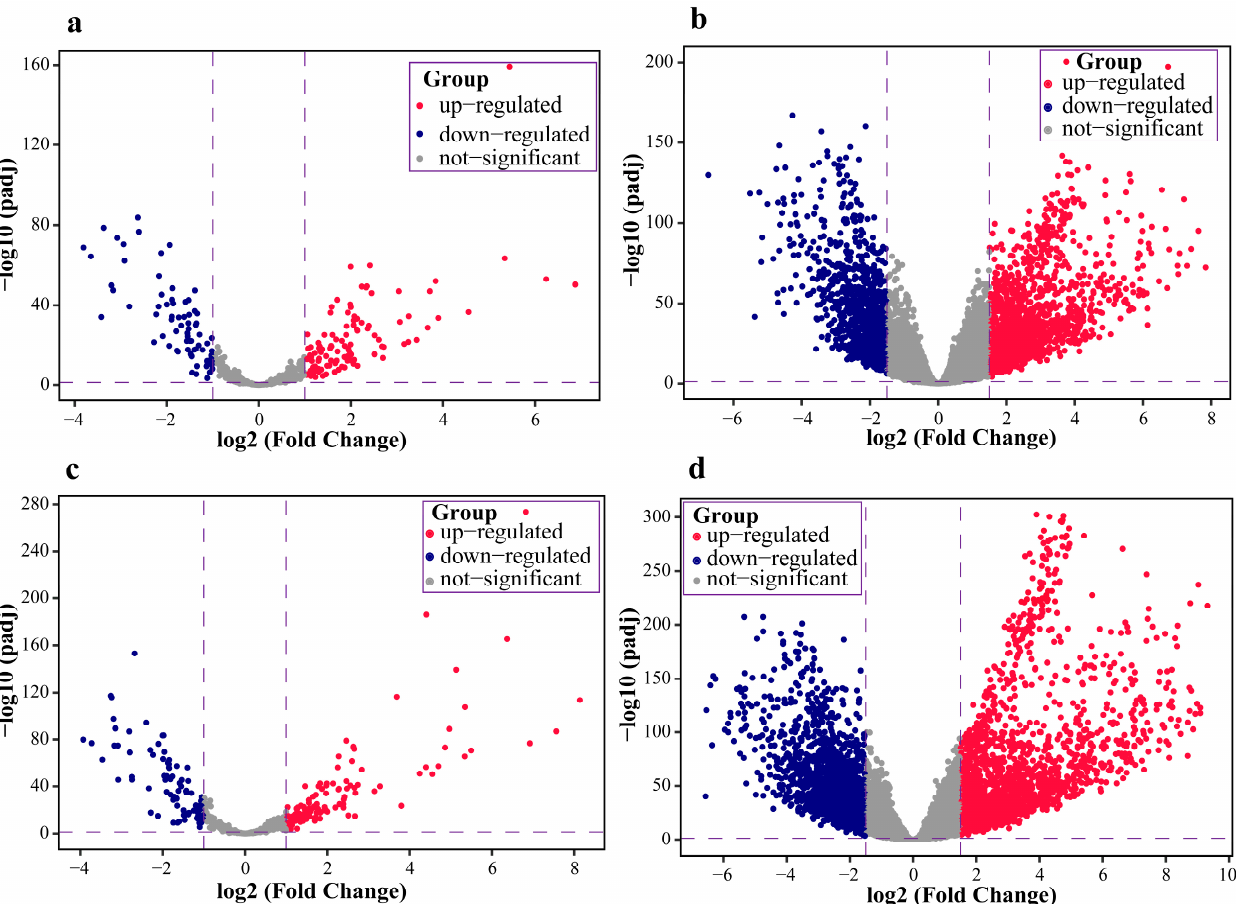
Figure 2. Volcano plot of miRNAs and mRNAs in LUAD and LUSC datasets: ( a , b ) indicate the volcano plot distribution of miRNAs and mRNAs in LUAD, respectively; while ( c , d ) indicate the volcano plot distribution of miRNAs and mRNAs in LUSC, respectively.